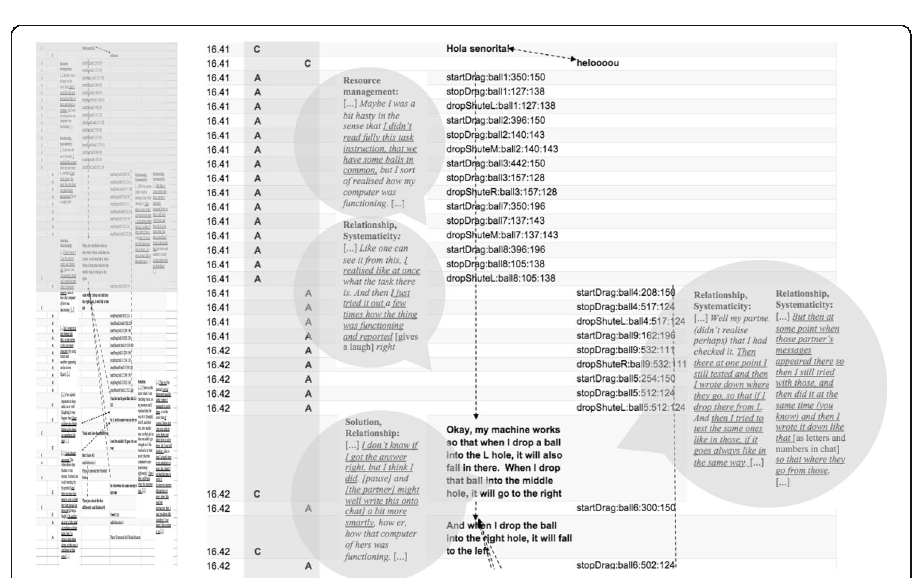
Fig. 7 Individual solution endeavour (pair 29, Laughing Clowns). The full episode as a general pattern of interaction is presented on the left. On the right, an excerpt (indicated as a grey area in the full episode) is presented, including a time-stamped, condensed activity pattern (A = action, C = chat). The dialogue is extracted from the activity log, and the speech bubbles contain excerpts from the coded CRR data that are related to the content of the particular excerpt. (Translated from Finnish). (The full episode is available also in Fig. 11 in Appendix